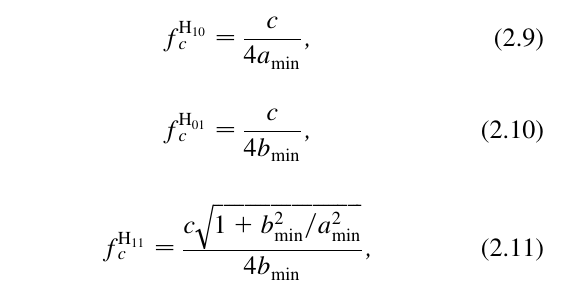
, , and modes in elliptical waveguide. H H H C 11 S 11 S 21